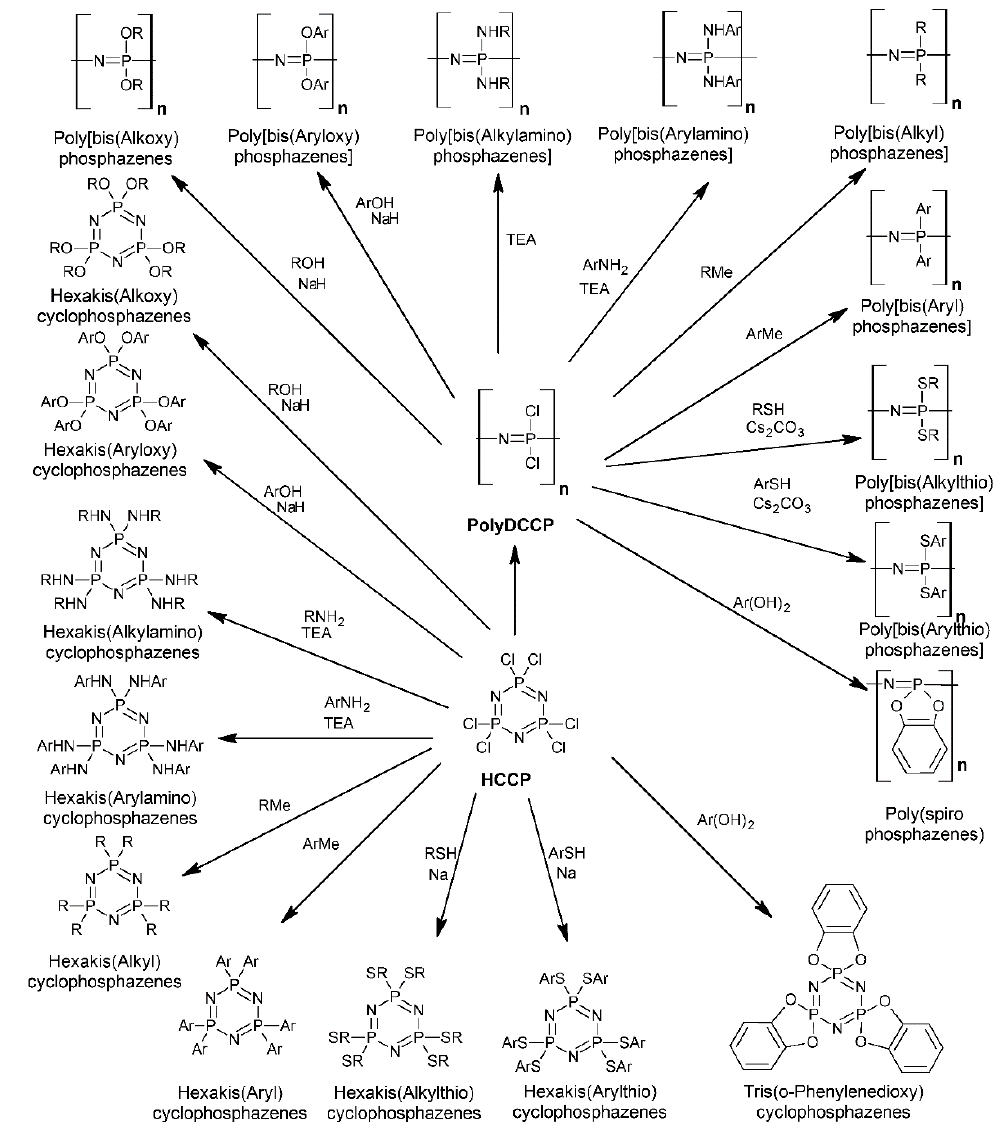
Scheme 2. From HCCP and polydichlorocyclophosphazene (PolyDCCP) to a wide variety of derivatives by nucleophilic substitution.